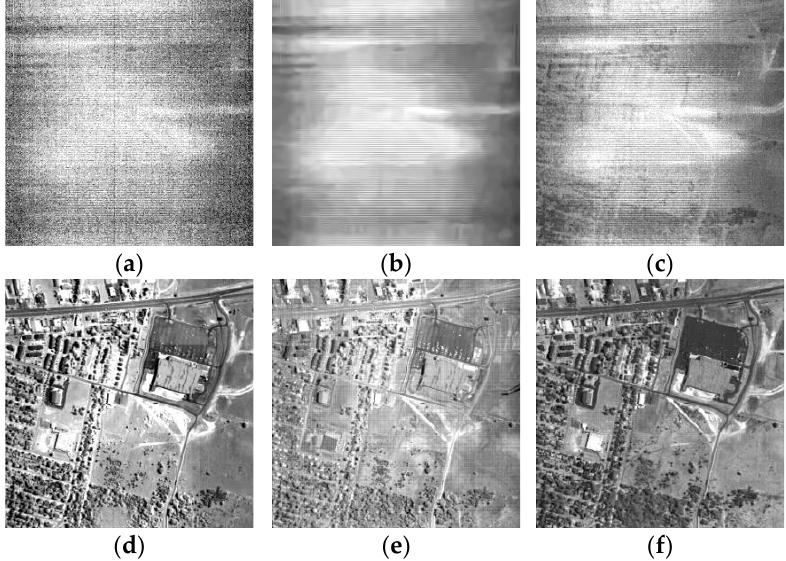
Figure 8. Inpainting results of band 144 of Urban dataset. ( a ) Original image; ( b ) PDE; ( c ) UBD; ( d ) LLRSSTV; ( e ) BPFA; and ( f )